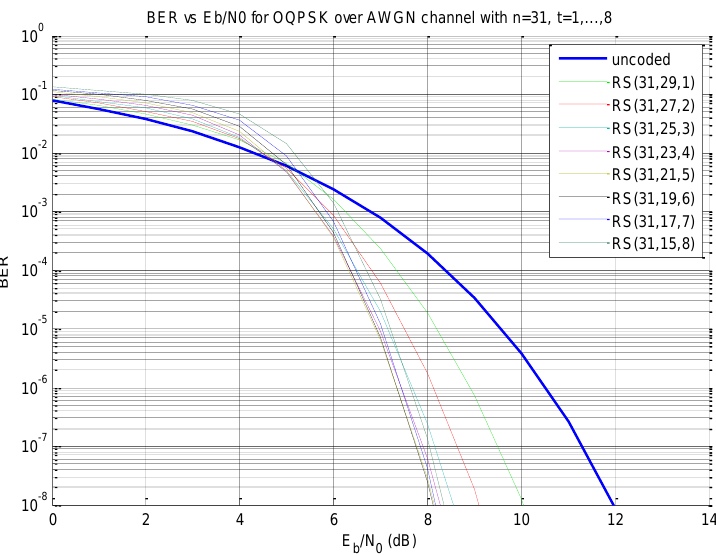
Figure 6. RS error performance for OQPSK over AWGN channel with constant n and increasing